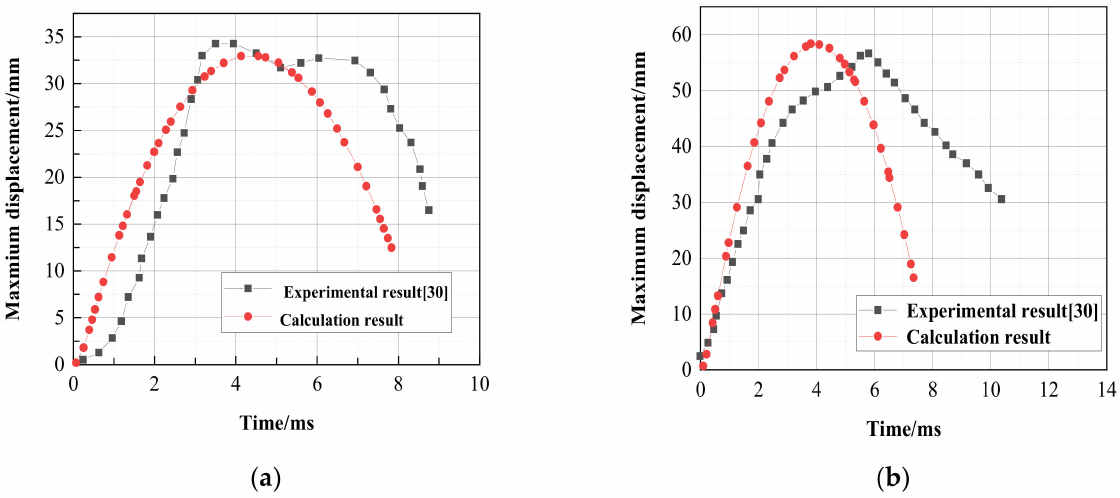
Figure 5. Comparison between the experimental results and ESDOF calculation results. ( a ) Compar- ison of time–displacement curves for working condition 1. ( b ) Comparison of time–displacement curves for working condition